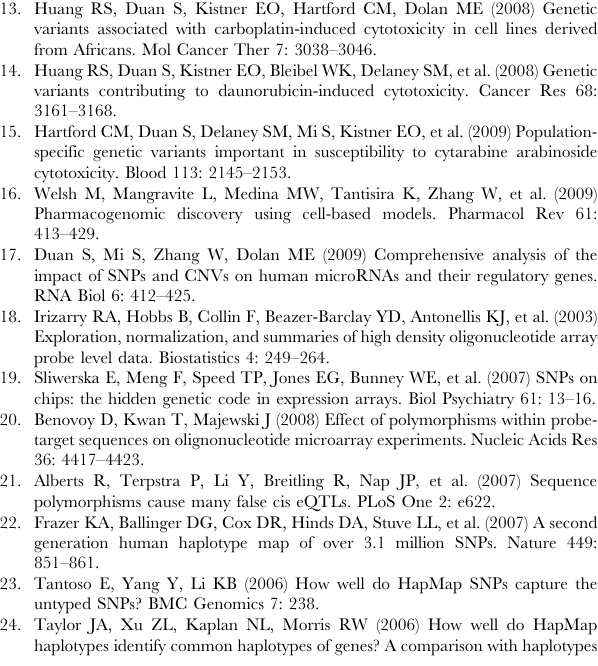
Table S5 A list of SNP-containing probesets (exon-level) for the YRI samples.